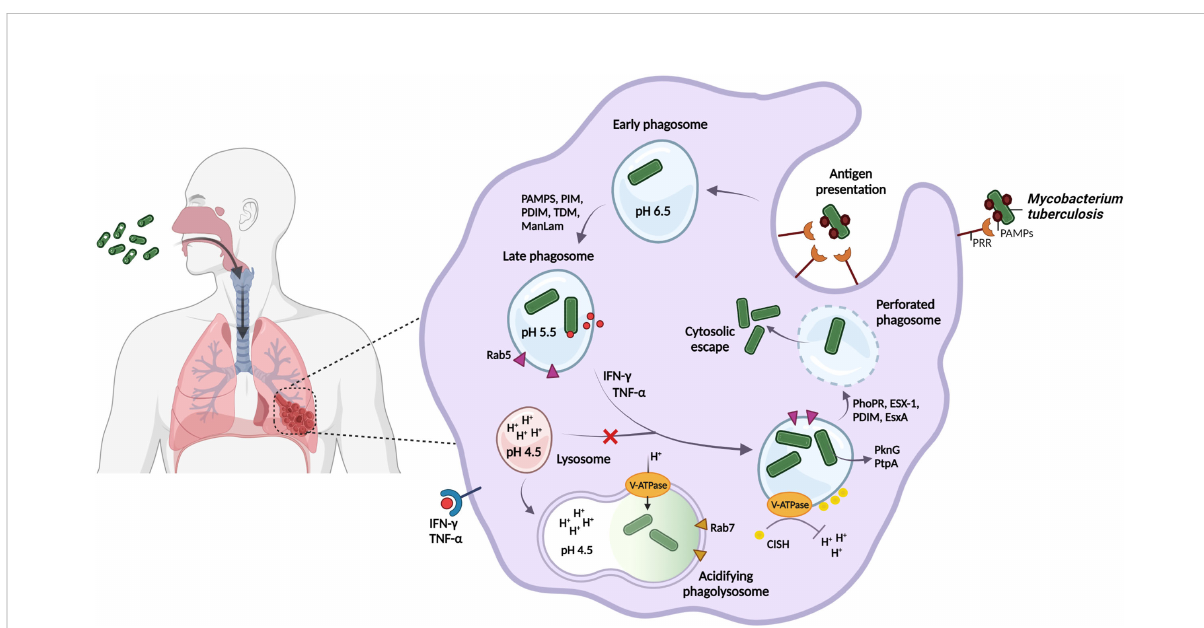
FIGURE 1 M. tuberculosis regulates phagosomal pH and blocks phagolysosome formation to avoid degradation by host acidic stressors and promote persister formation. M. tuberculosis is spread through the inhalation of aerosolized droplets that are released into the air when an infected individual coughs or sneezes. Host recognition of M. tuberculosis -speci fi c PAMPs results in the internalization into the phagosome of alveolar macrophages for bacterial containment. M. tuberculosis may however interfere with host cellular processing and the host immune response by retaining its interaction with the host early phagosomal marker, Rab5, and by selectively engaging host receptors, as a strategy to enhance intracellular survival in the phagosome. Following host immune activation by IFN- ƴ and TNF- a , phagosomal acidi fi cation to pH 4.5 is proposed. M. tuberculosis inhibits phagolysosomal fusion and regulates the phagosomal pH by the V-ATPase proton pump to resist degradation by the acidic environment. M. tuberculosis recruits the host CISH protein to degrade V-ATPase for neutralization of the vacuole. Finally, ESX-1 and the mycobacterial cell envelope lipid PDIM, act in synergy to perforate the phagosome, which promotes cytosolic displacement of bacteria, and is a crucial step for intracellular persistence. Created with